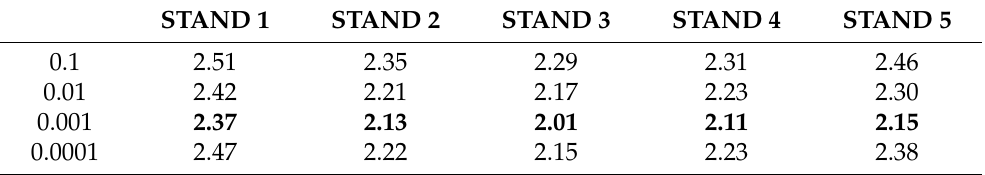
Table 6. Experimental results with various learning rates for the motor load prediction models. (The number of hidden layers: 1. The number of hidden nodes: 700. Activation function: ReLU.)